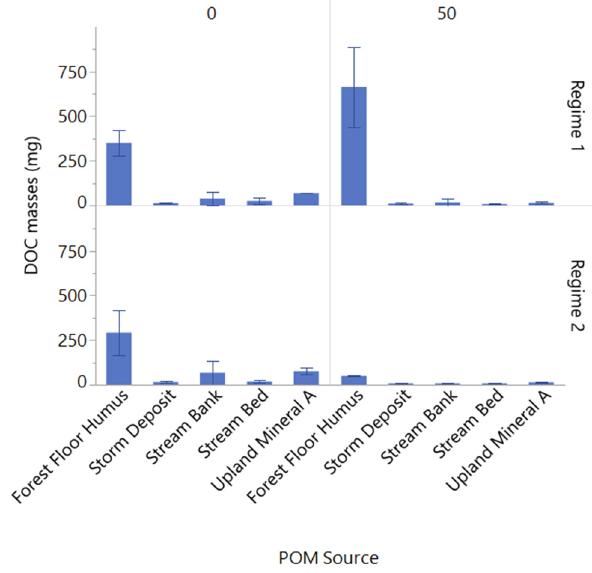
Figure 4. Porewater masses of N species for the five sources and two moisture regimes for day 0 and day 50. Regime 1: continuously moist and regime 2: dry–wet cycle.